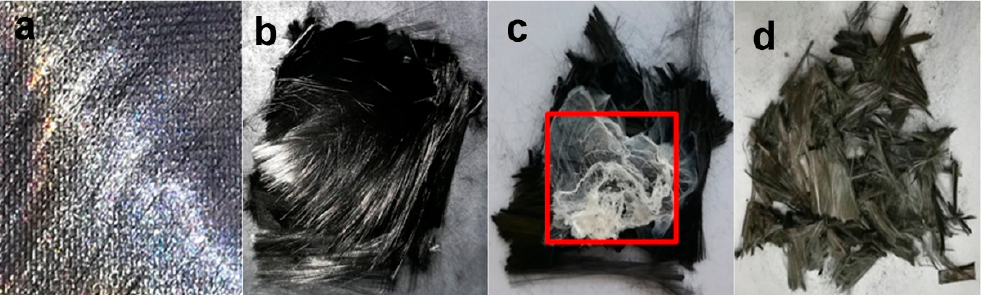
Figure 4. The macroscopic appearances of the CFRP waste samples after experiments: ( a ) 30 min of traditional heating at 400 °C, ( b ) 30 min of traditional heating at 450 °C, ( c ) 30 min of traditional heating at 500 °C, ( d ) 13 min of microwave heating at 450 °C.